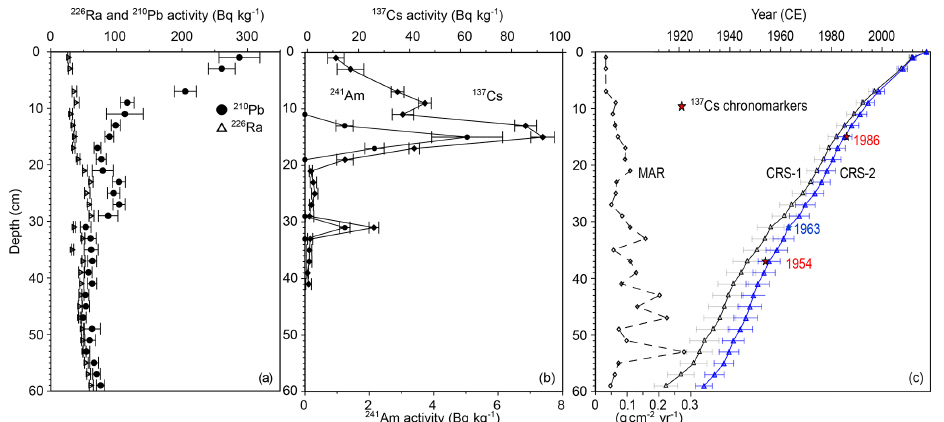
Figure 2. (a) Total 210 Pb, 226 Ra, and (b) 137 Cs and 241 Am activity concentration profiles in sediment core Burg17-B from Lake Burgäschi; (c) the comparison of different 210 Pb CRS models: unconstrained CRS-1 model and constrained CRS-2 model for 1963; the mass accumu- lation rates (MARs) are obtained from the CRS-2